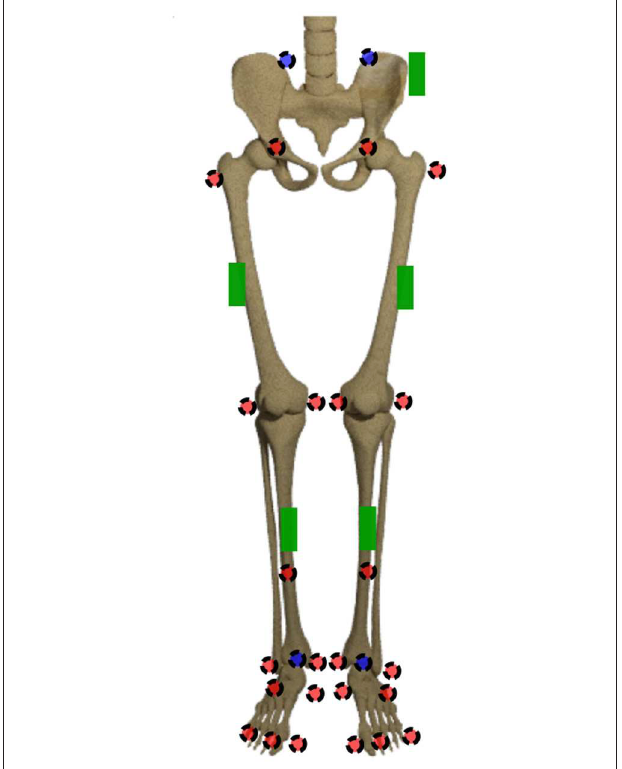
FIGURE 2 | Marker set and sensor placement. The markers in the front are displayed in red, the ones at the back are displayed in blue. The green boxes display the IMU